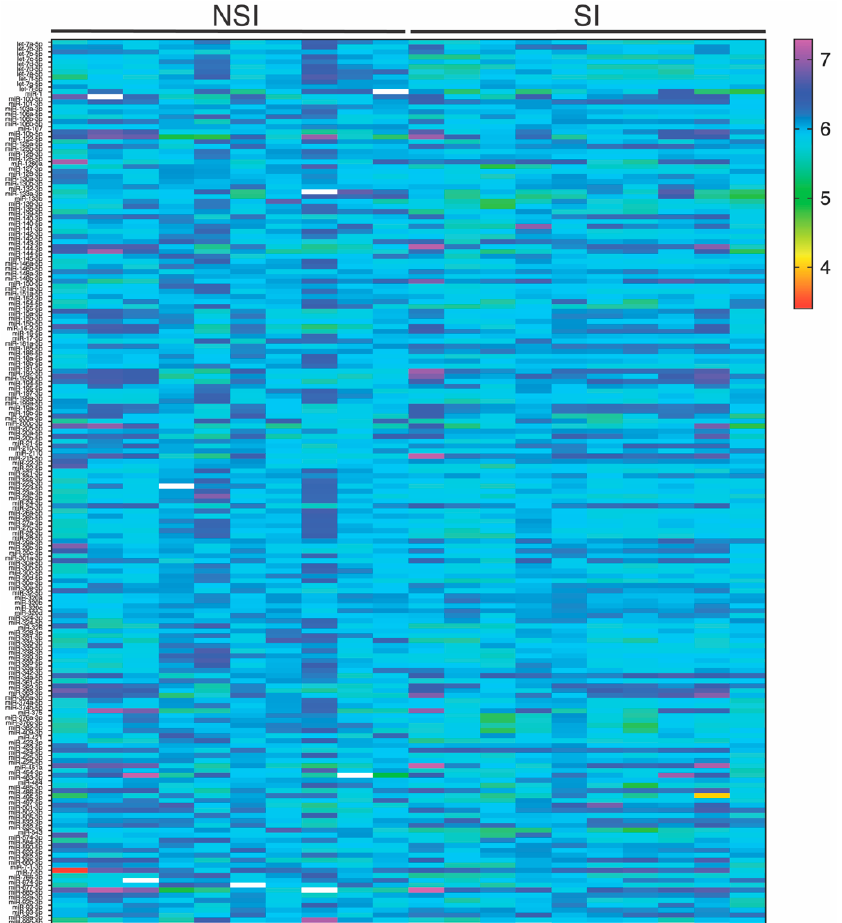
Figure 1. Color heatmap based on raw miRNA expression values where each column represents a patient, and each row represents a miRNA. The color scale illustrates the relative expression level of miRNAs (red and yellow represent low expression and blue and purple represent high expression). MiRNA expression levels were normalized to miR-148a-3p and let-7b-5p. MiRNA: microRNA; NSI: non-statin intolerant; SI: statin